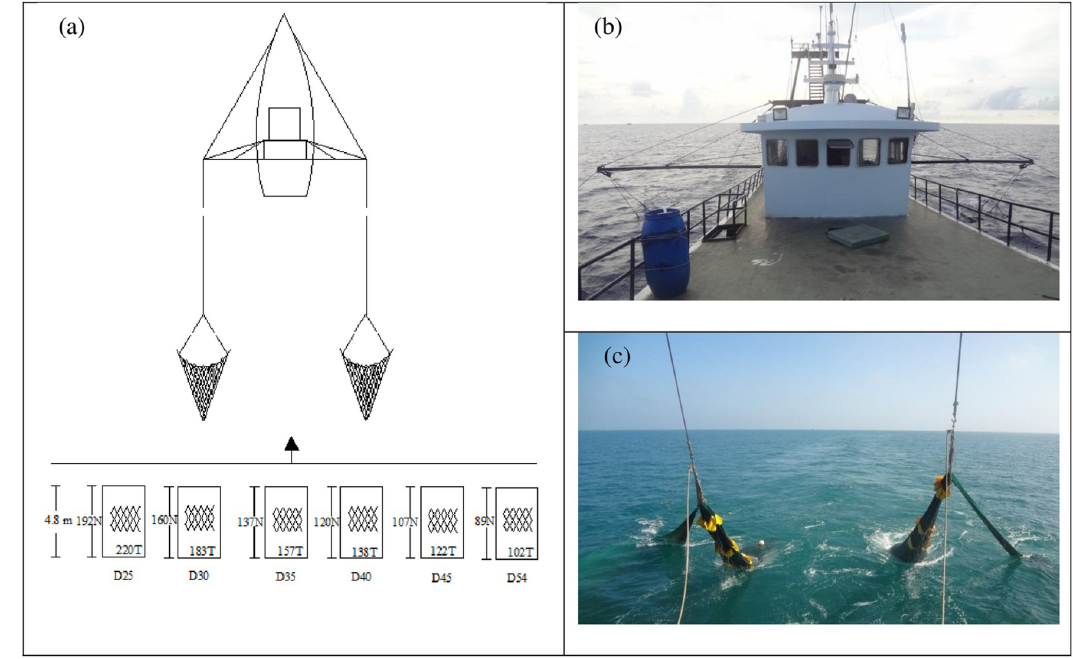
Fig 1. Schematic view of the fishing gear configuration tested in the experiments. (a): the fishing vessel and specification of the tested codends, (b): the vessel towing two trawls simultaneously, and (c): the haul-back process of the tested codends.